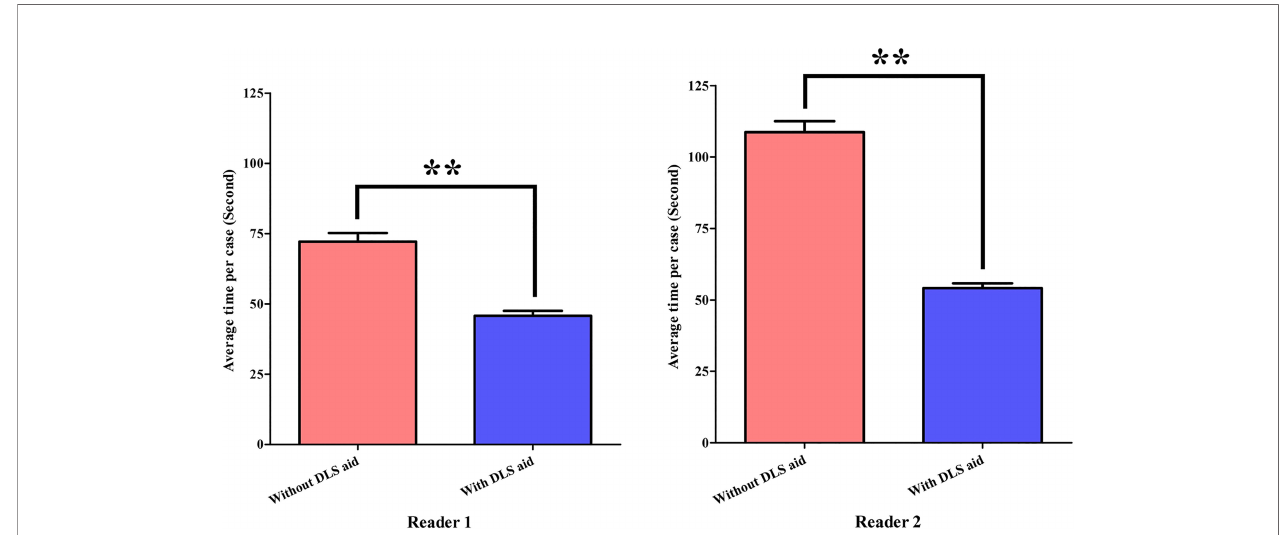
FIGURE 5 | Statistical comparison of radiologists ’ interpretation time. ** P <0.01. DLS, deep learning